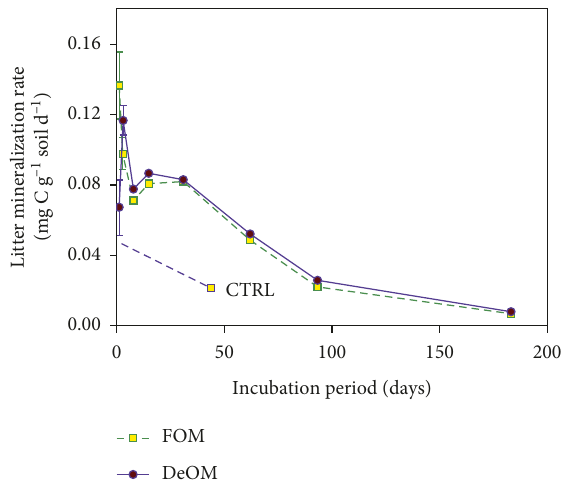
Figure 1: The patterns of carbon mineralization for different or- ganic materials.